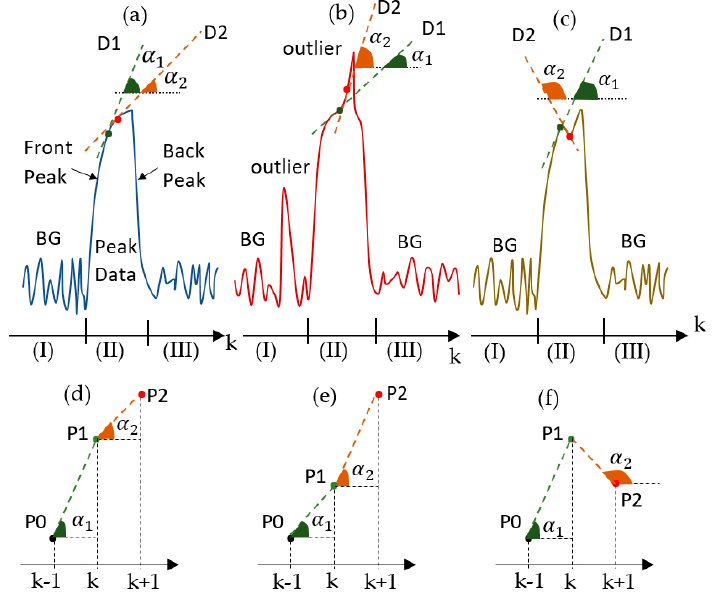
Figure 3. Three typical types of pulse data can be seen in the collected data. ( a ) Normal pulse data; ( b ) abnormal pulse data with positive outliers in the background and in the peak; ( c ) abnormal pulse data with a negative outlier in the peak and ( d – f ) close view of tangential line angles α 1 and α 2 of cases ( a ), ( b ) and ( c ) respectively.